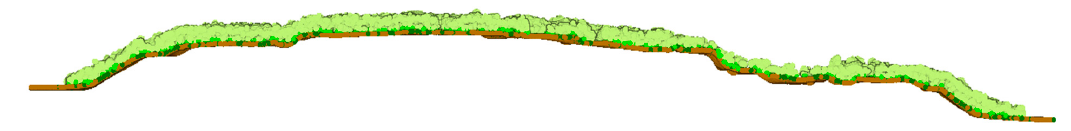
Figure 9. Terrain profile of the heap created based on LiDAR data.